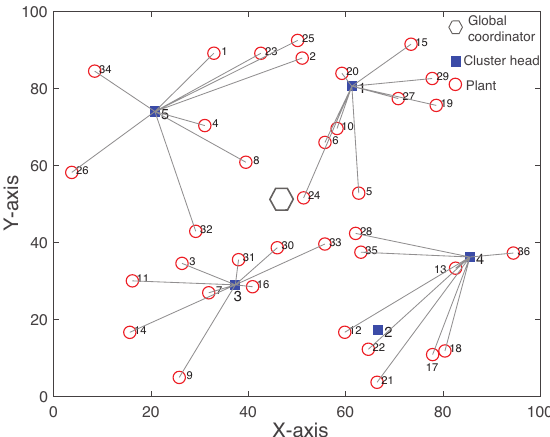
Figure 11. Reconfigured network clustering of the centralized approach after the inter-cluster link failure between global coordinator and cluster head